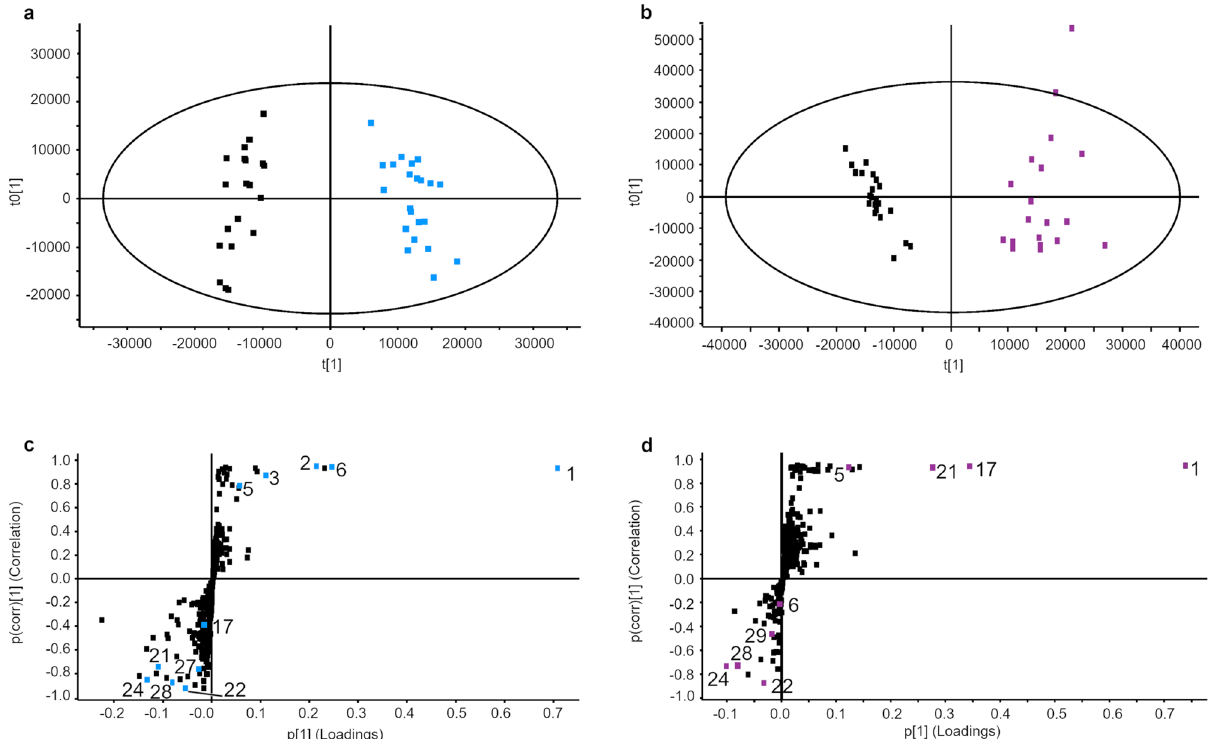
Fig. 1 OPLS-DA scores plots and corresponding S-plots based on UHPLC/Q-TOF-MS pro fi ling data of root extracts from VIGS and control lines. The OPLS-DA scores plots are shown in a , b for AbP450-5021 VIGS lines (blue) vs. control lines (black) (Pareto scaling, R2Y = 0.96, Q2Y = 0.94) and AbP450- 116623 VIGS lines (purple) vs. control lines (black) (Pareto scaling, R2Y = 0.94, Q2Y = 0.93), respectively. The data points in the OPLS-DA scores plots refer each to extracts of individual plants and are color-coded according to the genotype. The ellipse indicates 95% con fi dence. The covariance p[1] and correlation p(corr)[1] loadings from the two class OPLS-DA models are shown here in S-Plot format ( c control = − 1, AbP450-5021 VIGS = 1 and d control = − 1, AbP450-116623 VIGS = 1). In the S-plots, each point represents a different exact mass-to-charge ratio/retention time pair. The upper right quadrant of the S-plots shows exact mass-to-charge ratio/retention time pairs whose levels are higher in VIGS lines than in control lines, whereas the lower left quadrant indicates mass-to-charge ratio/retention time pairs whose levels are higher in control lines. The further along the x-axis the greater the contribution to the variance between the groups, while the further the y-axis the higher the reliability of the analytical result. Data points for selected metabolites are highlighted: pseudotropine ( 1 ), acetyl pseudotropine ( 2 ), propionyl pseudotropine ( 3 ), 5:0-acyl pseudotropine ( 5 ), tigloyl pseudotropine ( 6 ), norpseudotropine ( 17 ), calystegine A5 ( 27 ), calystegine A3 ( 28 ), calystegine B1 ( 29 ), tigloyl norpseudotropine ( 21 ), tigloyl hydroxynorpseudotropine isomer 1 ( 22 ), and tigloyl dihydroxynorpseudotropine isomer 1 ( 24